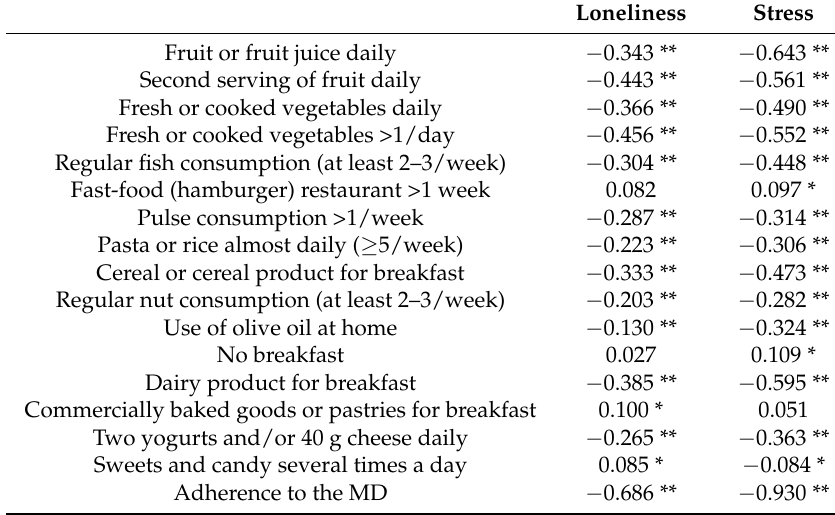
Table 2. Patterns of associations between dietary patterns, adherence to MD, perceived loneliness, and